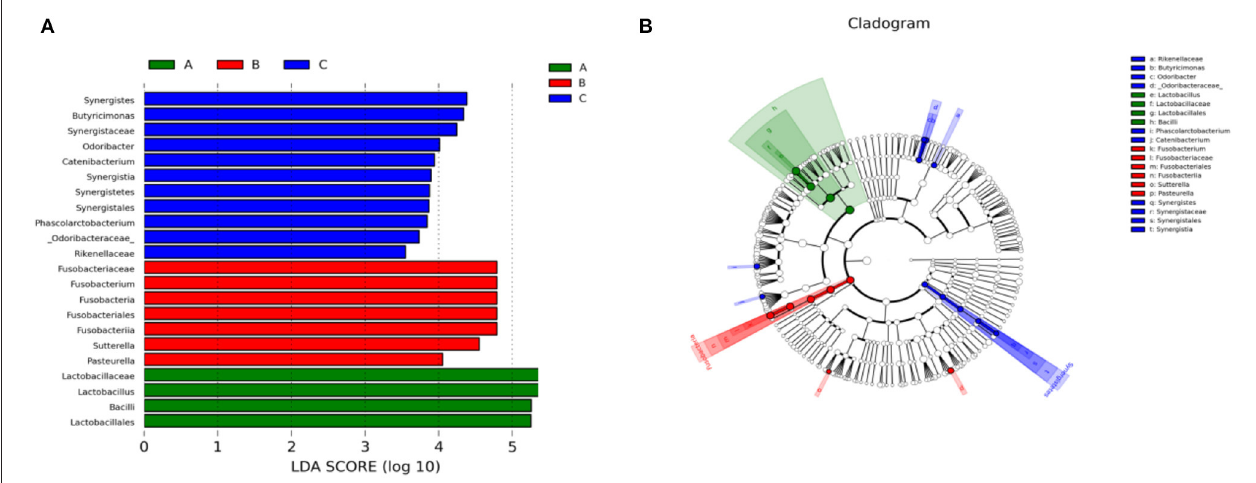
FIGURE 6 | Linear discriminant analysis effect size (LEfSe) analysis of fecal microbiota composition in different groups of Tibetan piglets. (A) Histogram of the Linear Discriminant Analysis (LDA) scores computed for bacterial taxa differentially abundant among different groups. (B) A cladogram showing statistically and physiologically consistent distinctions among different groups. A: Healthy piglets; B: Diarrheal piglets; C: Treated